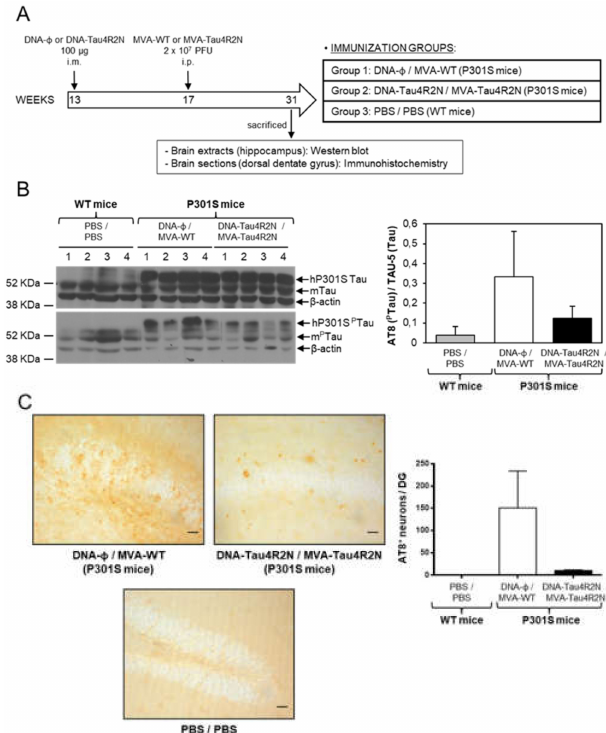
Figure 5. Studies on e ffi cacy of MVA-Tau4R2N in transgenic P301S mice. ( A ) Vaccination scheme. Groups of transgenic P301S mice ( n = 4 mice / group, 13 weeks of age) were immunized with 100 µ g of DNA-Tau4R2N (pSG5-Tau4R2N) or DNA- Φ (pSG5) by the i.m. route. Four weeks later (week 17), animals were immunized with 2 × 10 7 PFUs of MVA-Tau4R2N or MVA-WT by the i.p. route (see Materials and Methods). At week 31, animals were sacrificed and levels of hyperphosphorylated tau were determined by Western blot ( B ) and immunohistochemistry ( C ). ( B ) Detection of phosphorylated tau protein by Western blot in hippocampal samples of vaccinated P301S mice. Levels of human transgenic tau (hP301S) and endogenous murine tau (mTau) proteins were analyzed in hippocampal samples from C57BL / 6 WT mice vaccinated with PBS / PBS and from transgenic P301S mice vaccinated with DNA- Φ / MVA-WT or DNA-Tau4R2N / MVA-Tau4R2N. TAU-5 (upper panel) and AT8 (lower panel) antibodies, were used to detect unphosphorylated and phosphorylated tau protein, respectively. β -actin has been used as a loading control. A quantification of all the bands of unphosphorylated and phosphorylated tau proteins detected by Western blot was made using ImageJ software, and the percentage of phosphorylated tau ( P Tau) vs. unphosphorylated tau is shown in the graph, with error bars indicating the SEM. ( C ) Detection of phosphorylated tau protein by immunohistochemistry in dorsal dentate gyrus samples of vaccinated P301S mice. Immunohistochemistry was performed using the AT8 antibody to detect phosphorylated tau. Representative pictures from C57BL / 6 WT mice vaccinated with PBS / PBS and transgenic P301S mice vaccinated with DNA- Φ / MVA-WT or DNA-Tau4R2N / MVA-Tau4R2N are shown. Scale bar: 20 µ m. In the graph a quantification of the mean number of AT8 + cells per dorsal dentate gyrus (granule-cell layer) in 50- µ m-thick sections is shown; error bars indicate the